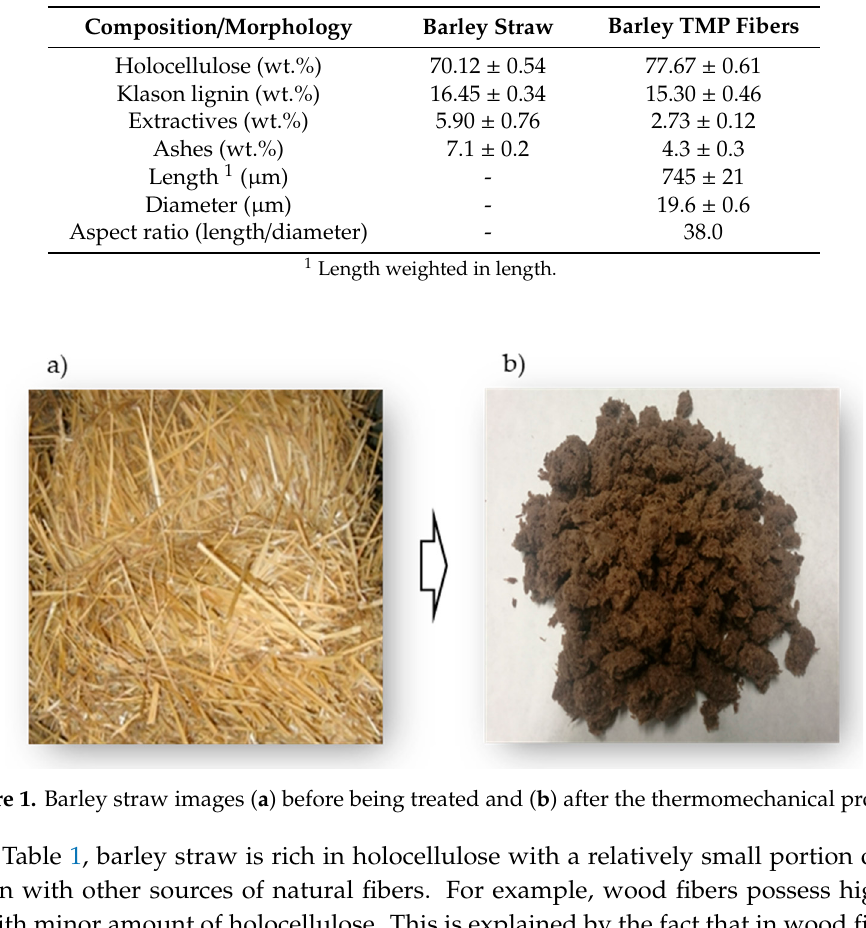
Table 1. Chemical and morphological composition of barley straw and barley thermomechanical (TMP) fibers.